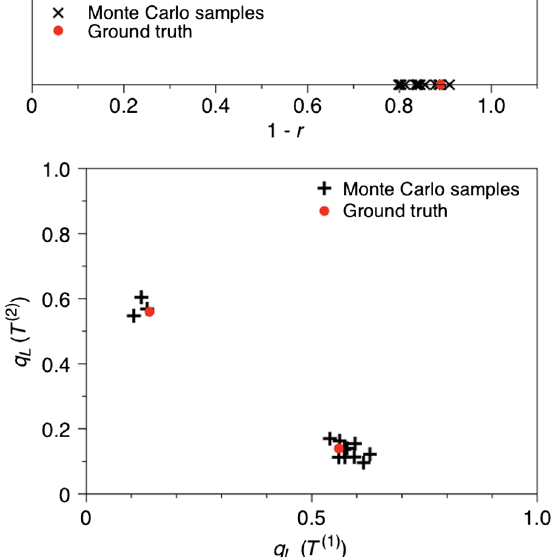
FIG. 19. Scatter plots of 100 Monte Carlo samples of 1 − r (top panel) and the interlayer transition probabilities T ð 1 Þ and T ð 2 Þ (bottom panel). They are all concentrated in a region close to the ground truth (note that there are two clouds in the bottom panel due to the symmetry T ð 1 Þ ↔ T ð 2 Þ ).